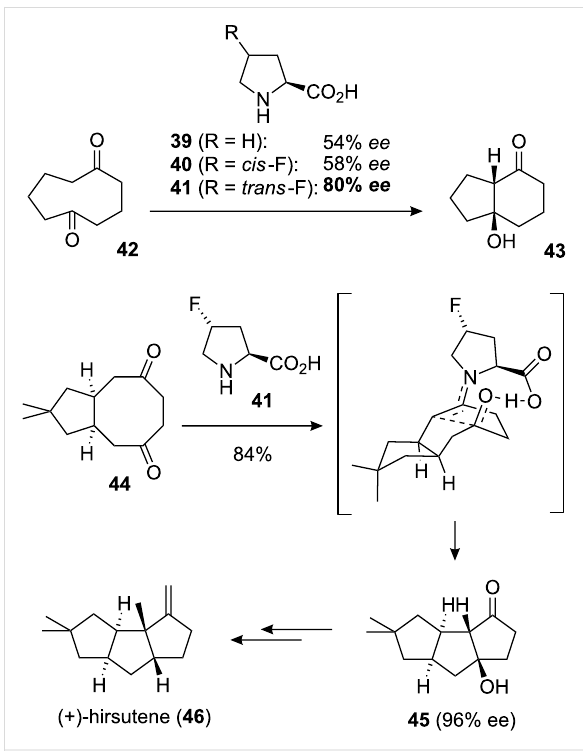
Figure 10: The asymmetric transannular aldol reaction catalysed by trans -4-fluoroproline ( 41 ), and its application to the total synthesis of (+)-hirsutene ( 46